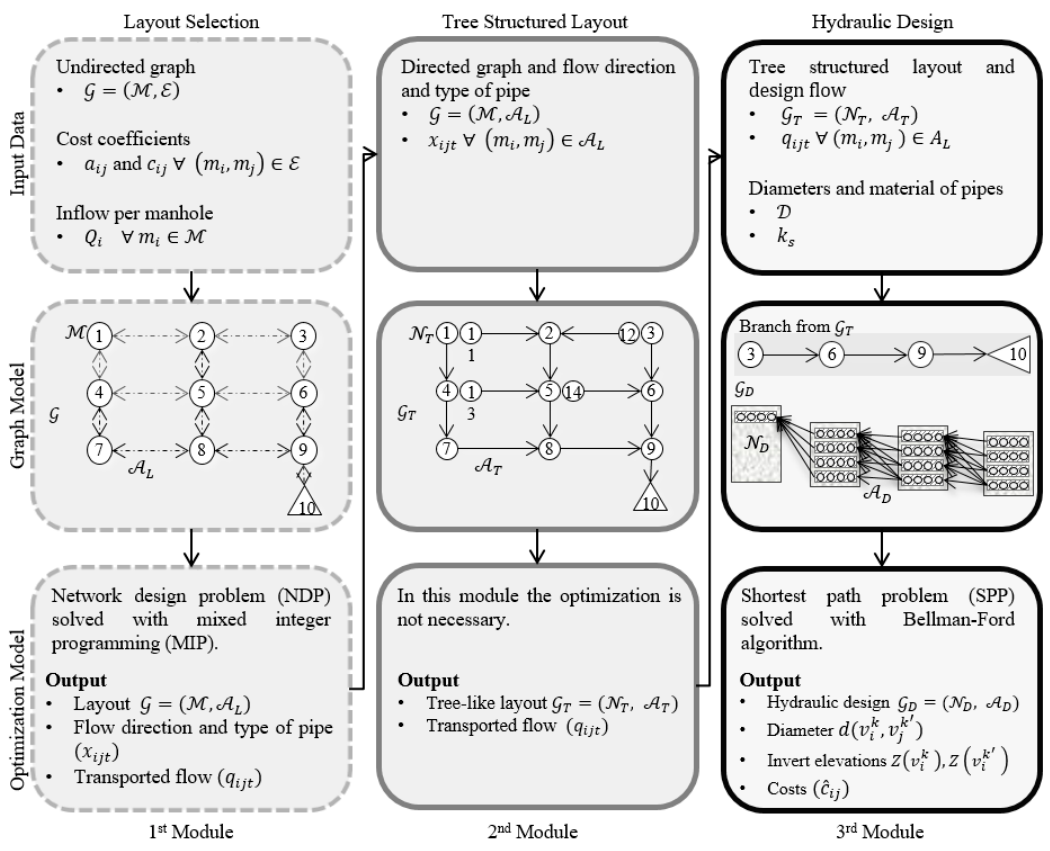
Figure 4. Sewer networks design (SND) modules and modelling frameworks for a single iteration.